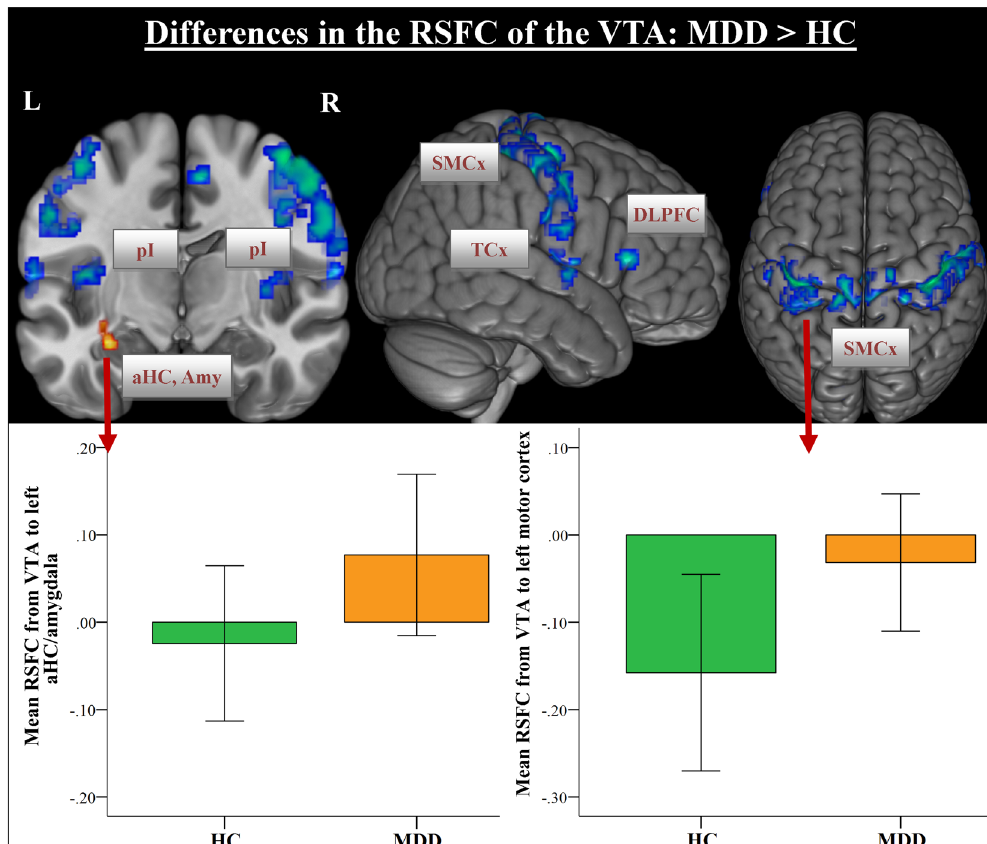
Figure 2. Whole-brain resting-state functional connectivity maps with seed region in the ventral tegmental area (VTA). The comparison between depressed patients vs. healthy controls demonstrated that patients had stronger functional connectivity from VTA to the left amygdala (yellow color) and absent “anti-correlation” from VTA to the sensorimotor and temporal cortices, posterior insula and the right DLPFC (blue color). The error bars in the graphs of the RSFC from VTA to the amygdala as well as to the motor cortex represent standard deviations. Abbr.: aHC, anterior hippocampus; Amy, amygdala; pI, posterior insula; DLPFC, dorsolateral prefrontal cortex; SMCx, sensorimotor cortex, TCx, temporal